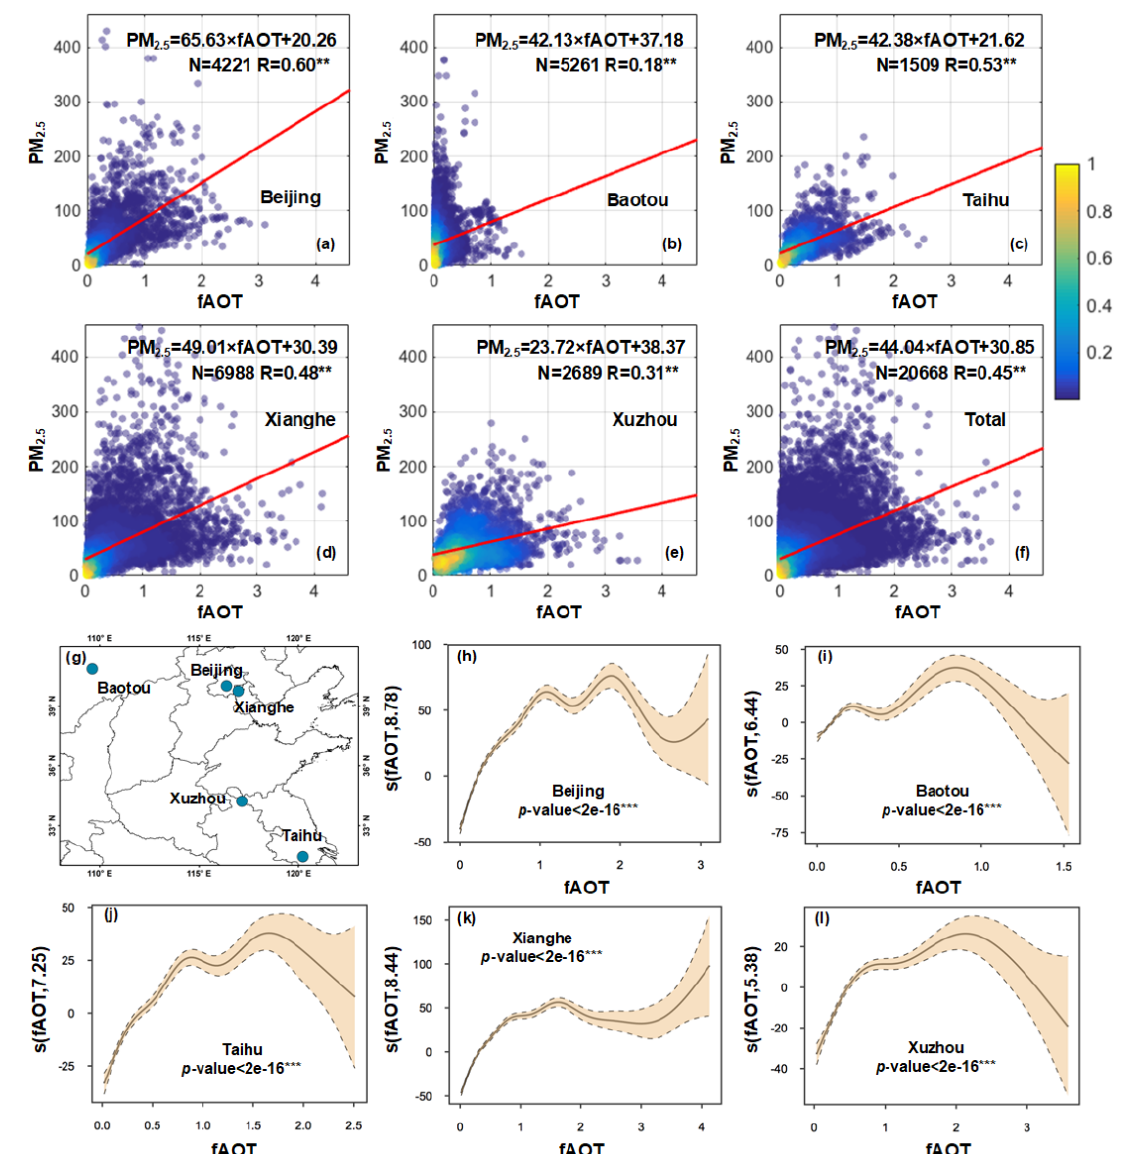
Figure 4. ( a – f ) The linear correlation of fAOT with PM 2.5 over five stations (Beijing, Baotou, Taihu, Xianghe, Xuzhou) each and total in China during 2015–2019. The red lines represent fitting lines and the “**” after each R value represents the correlation significance > 95%, ( g ): the location of the 5 stations. ( h – l ): the GAM plots of fAOT and PM 2.5 in five AERONET stations over China. The light brown shaded color represents the 95% confidence interval of fitting, and the y -axis represents the smooth fitted values with the degrees of freedom of fitting shows in the parentheses. The p -value attached with “***” means the significant GAM fitting at 99% significance level.